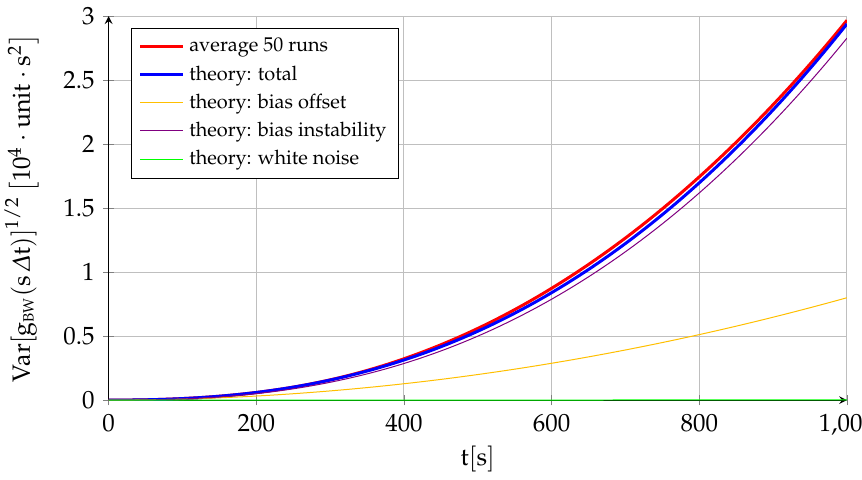
Figure 7. Propagation with time of second integral of sensor error standard deviation.